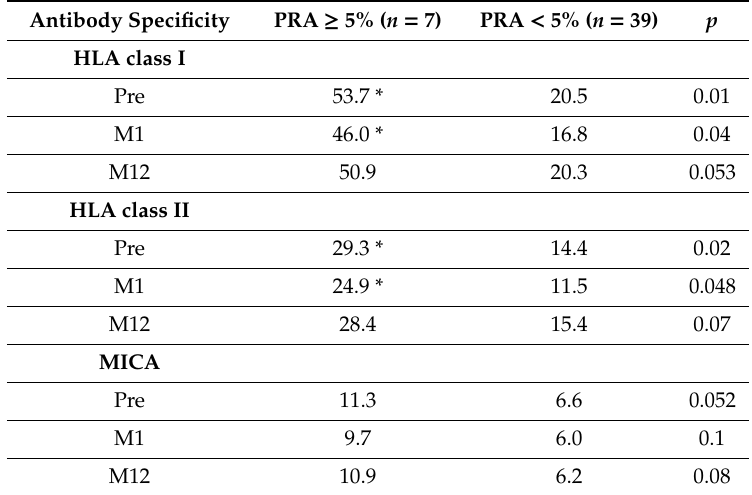
Table 7. Comparison of kidney transplant recipients with and without panel-reactive antibodies (maximum PRA < 5%) prior to transplantation. Antibody scores were analyzed pre-vaccination and at month 1 (M1) and month 12 (M12) after vaccination with